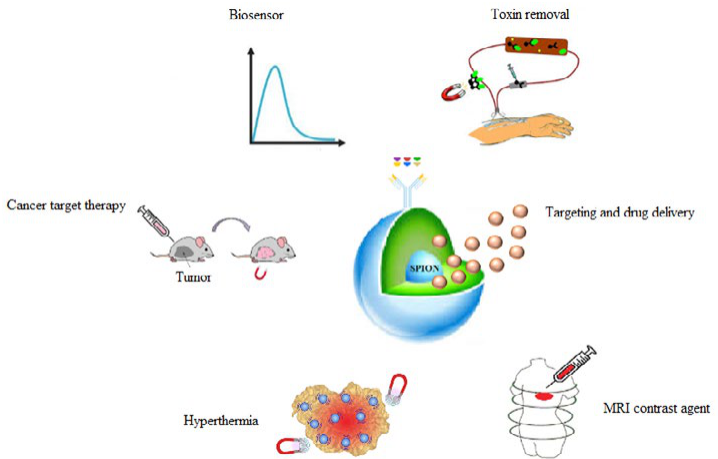
Fig. 1: Superparamagnetic iron oxide nanoparticles (SPION)